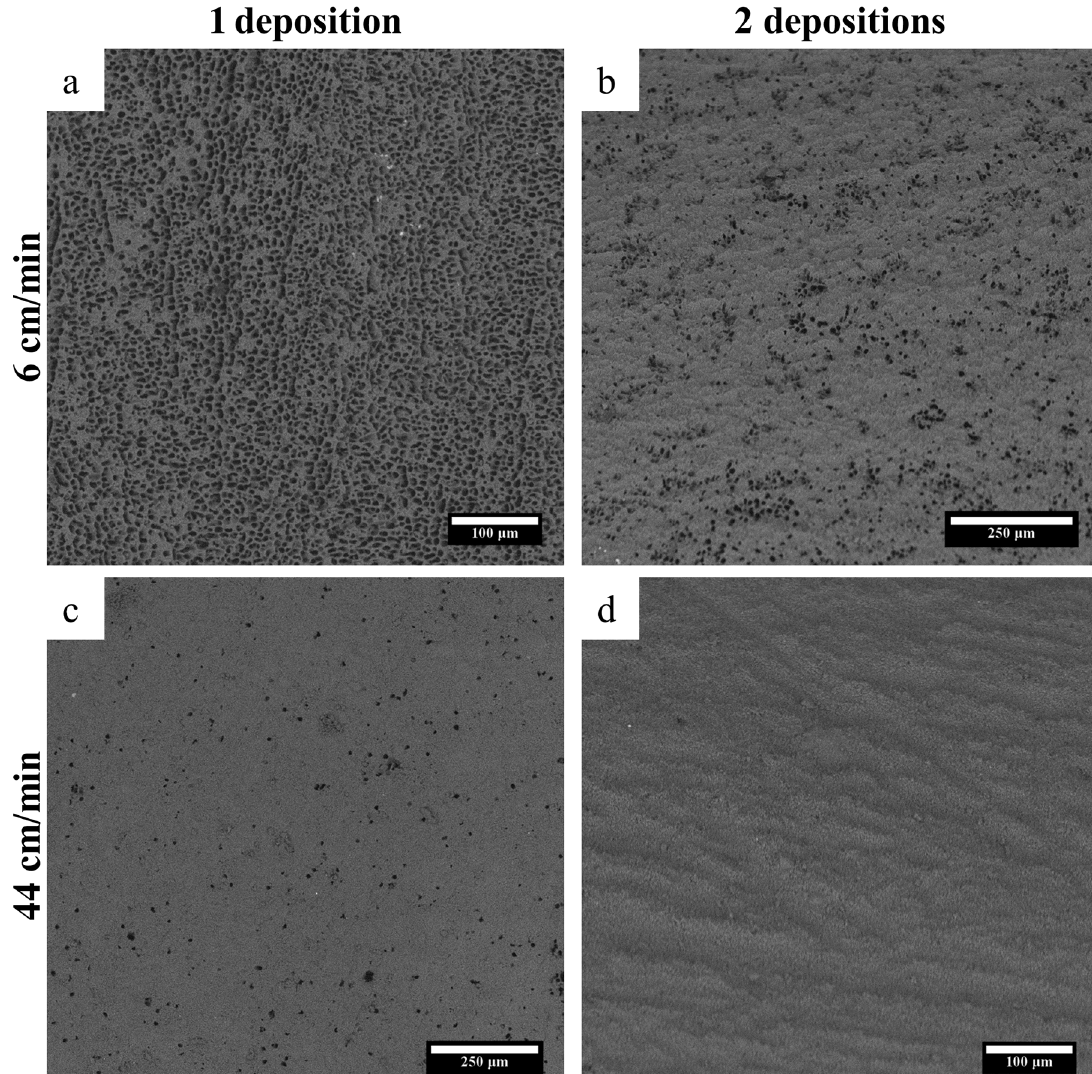
Figure 10. SEM images (backscattered electrons) detailing the deposition of the silica top layer on the freeze-cast